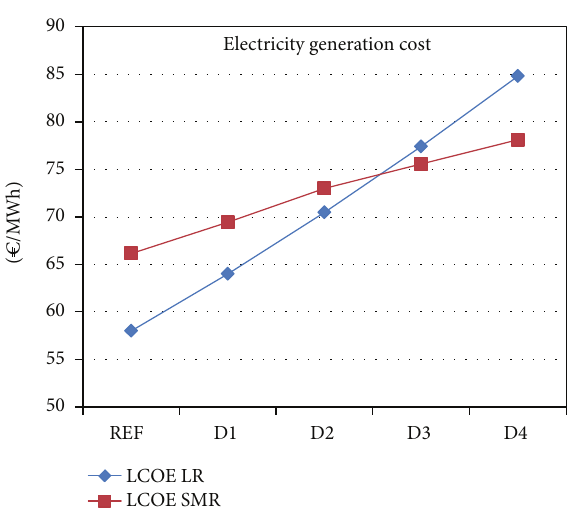
Figure 10: LCOE sensitivity with increasing delay in construction schedule [22].